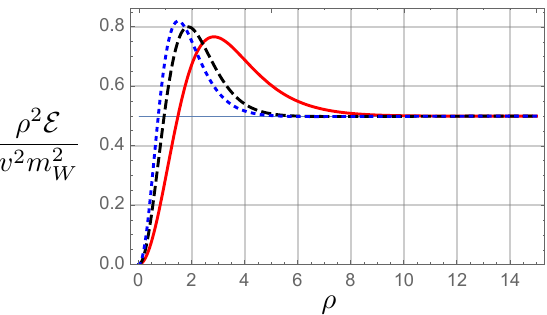
Figure 2 . (cid:26) 2 =v 2 for the non-Abelian strings with ( (cid:13) 1 ; (cid:13) 3 ) = (1 ; 1 E (black dashed curve), and (1 ; 2) (blue dotted curve). All the curves converge to 1 = 2, indicating the fractional U(1) a winding number, as expected from eq.